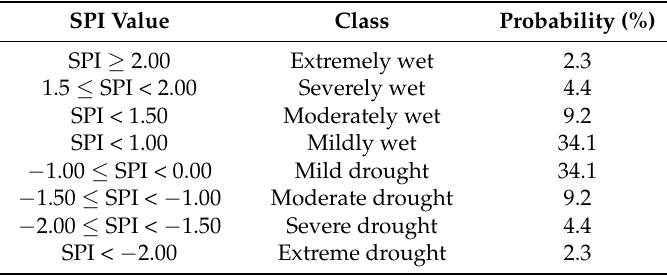
Table 1. Climate classification according to the Standardized Precipitation Index (SPI)